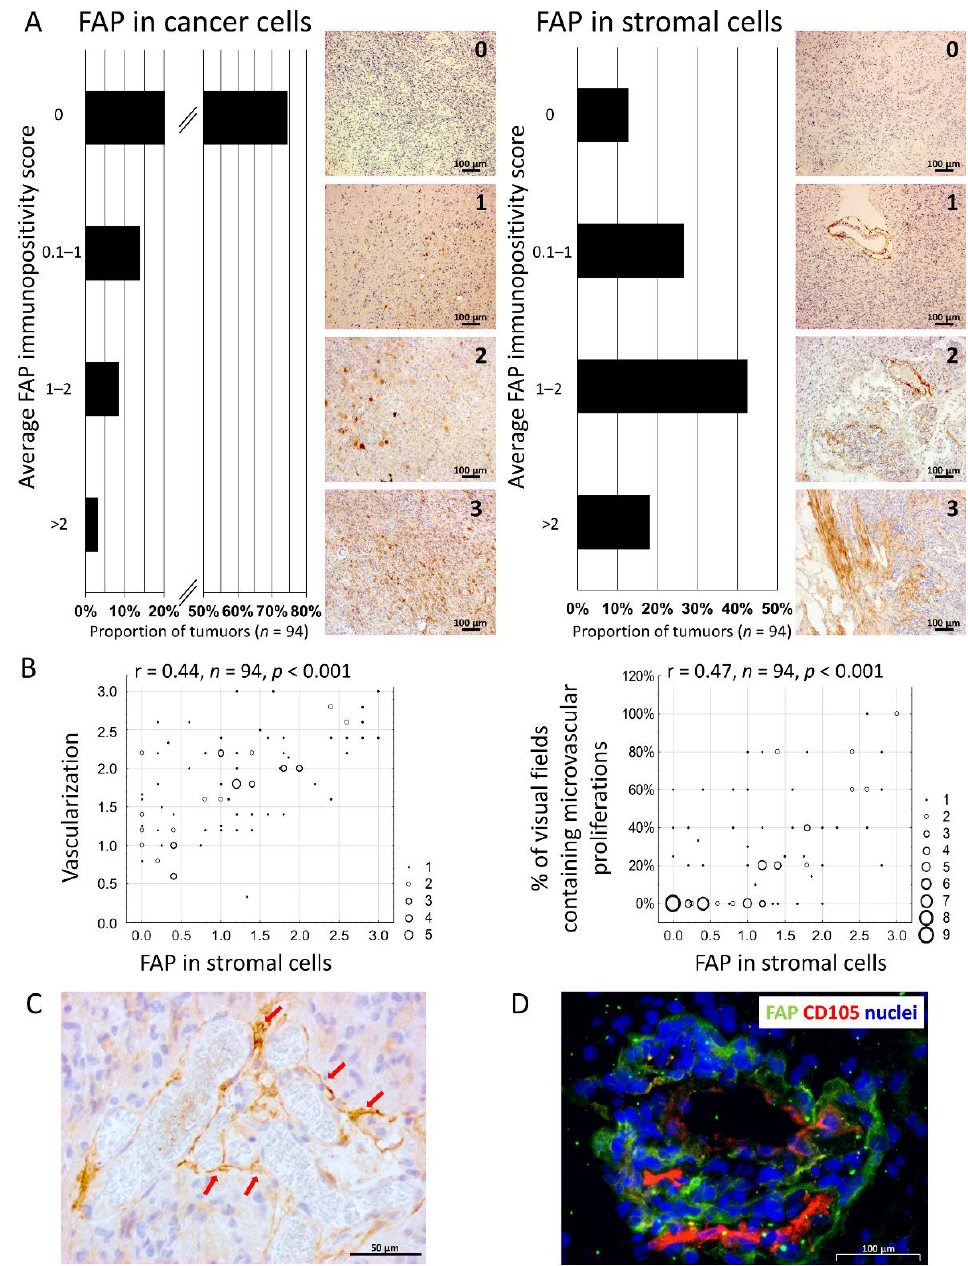
Figure 1. The quantity of FAP-expressing stromal cells correlates with vascularisation in glioblas- toma. ( A ) Summary of FAP expression in cancer and stromal cells in glioblastomas evaluated by immunohistochemistry ( n = 94, average immunopositivity score for each tumour was calculated from five independent microscopic fields, depicted are representative images illustrating the four-tiered semiquantitative scale used to evaluate FAP expression). ( B ) Correlation between FAP expression in stromal cells, vascularisation, and the presence of microvascular proliferations. Frequencies of overlapping points between two variables are illustrated by the size of the point markers. Kendal correlation coefficient was used for the statistical evaluation of the data. ( C ) A representative image of dysmorphic, tortuous, and hyperplastic blood vessels surrounded by FAP-expressing cells (red arrows). ( D ) A representative image of CD105 + endothelial cells surrounded by FAP-expressing stromal cells. Nuclei were counterstained with Hoechst.